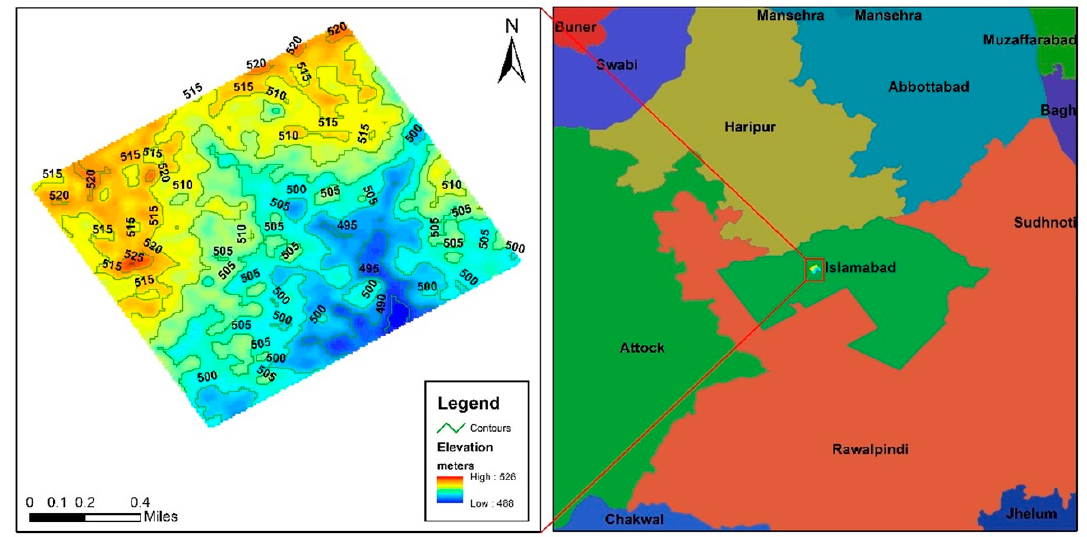
Figure 1. Location Map of Fatima Jinnah Park (F9-Park) ICT, showing the elevation of the study area along with contours at 2 m interval.